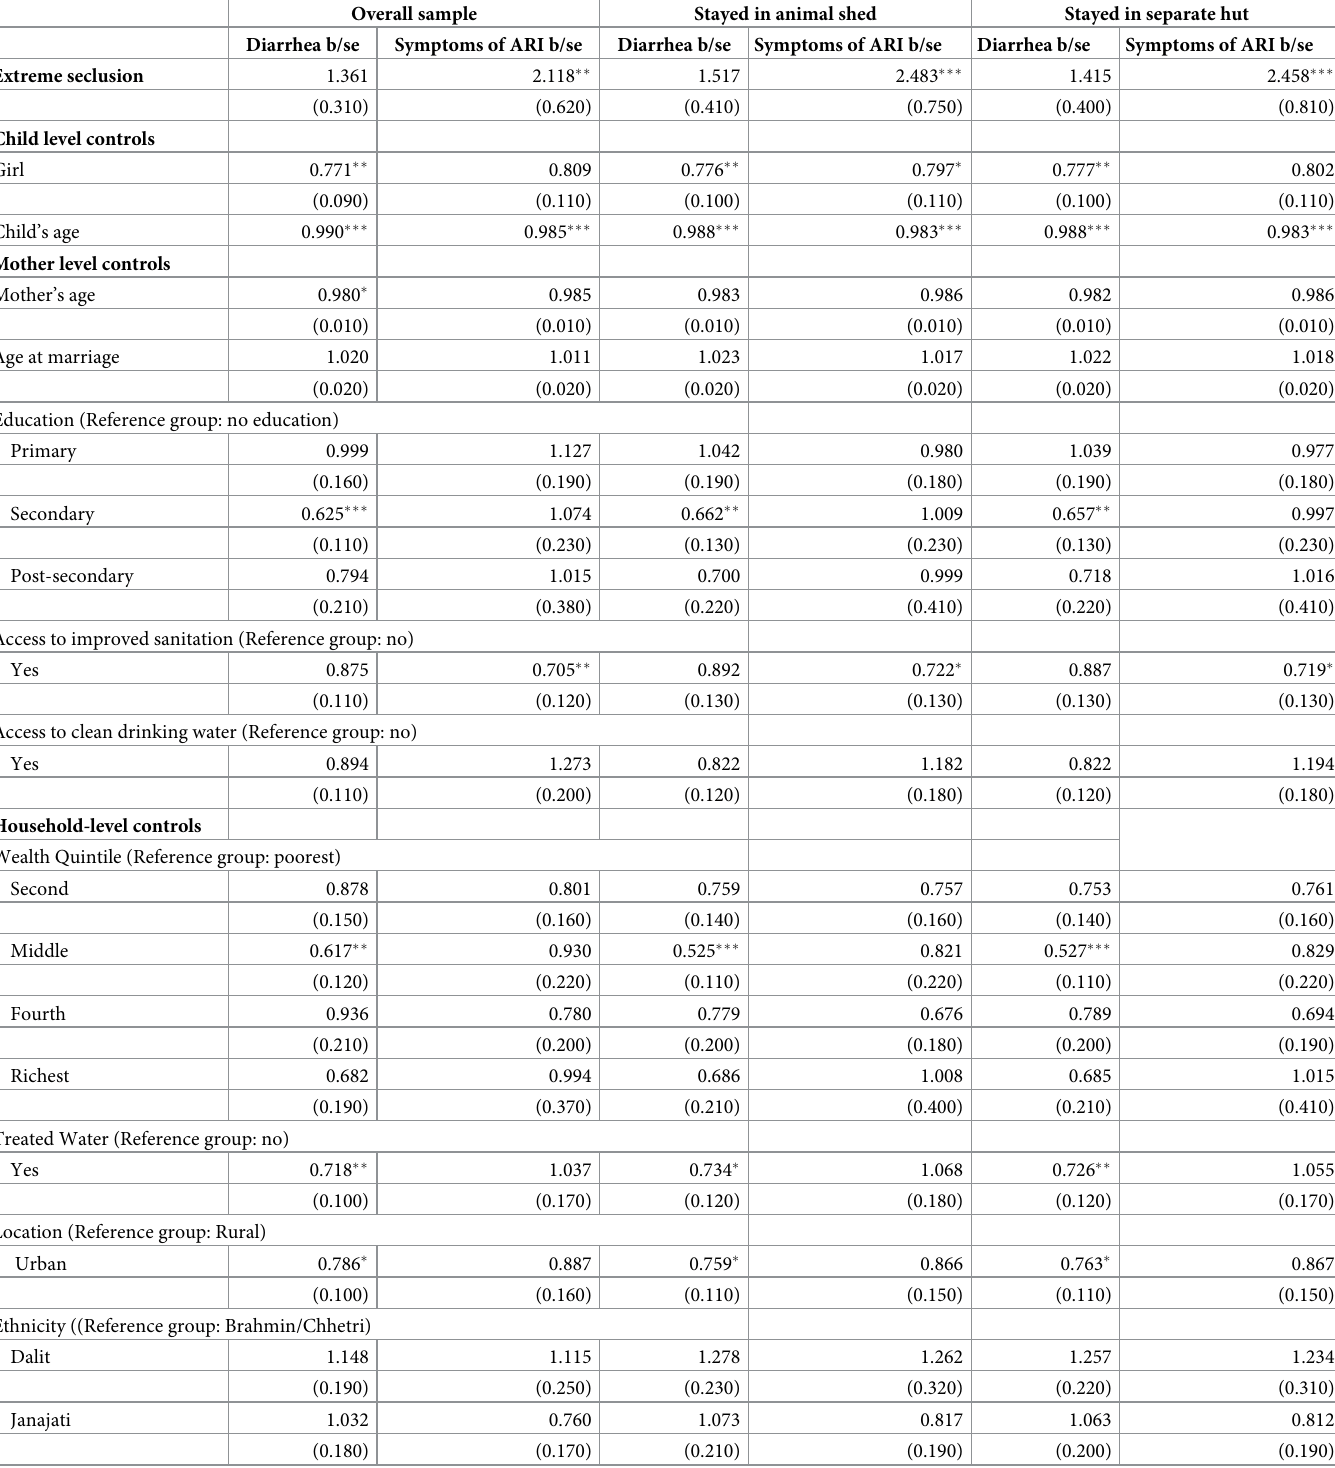
Table 3. Odds ratios from logistic regressions of incidence of diarrhea and symptoms of Acute Respiratory Infection (ARI) among children 5–59 months on whether the mother stayed separately in animal shed or hut during